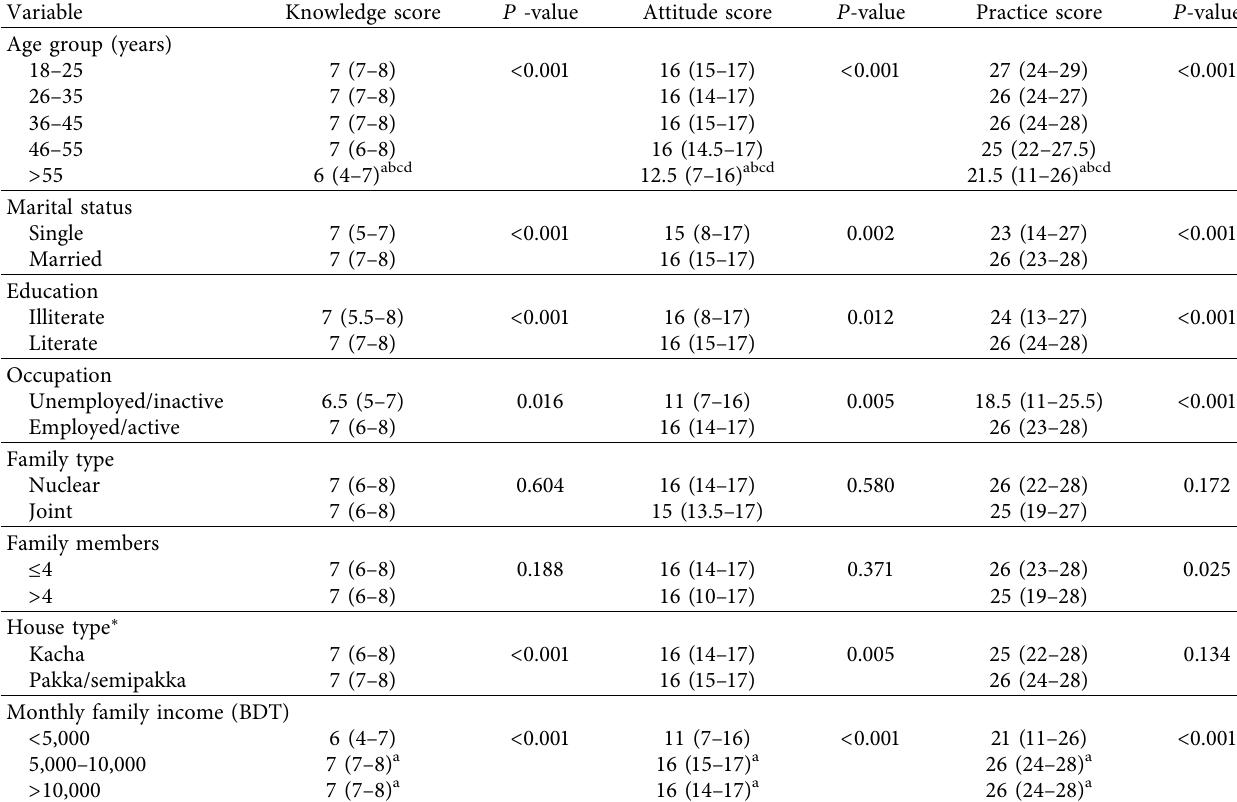
Table 5: Knowledge, attitude, and practice scores by participant